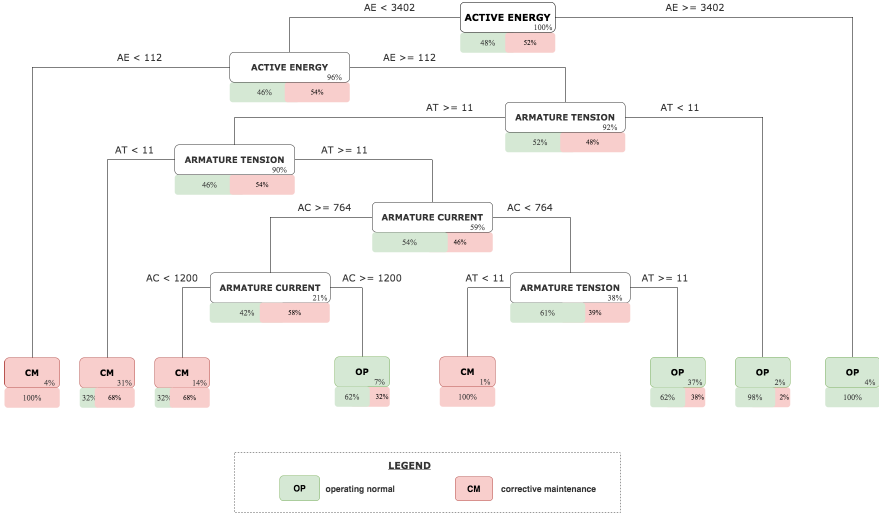
Figure 9. Predictive Decision Tree